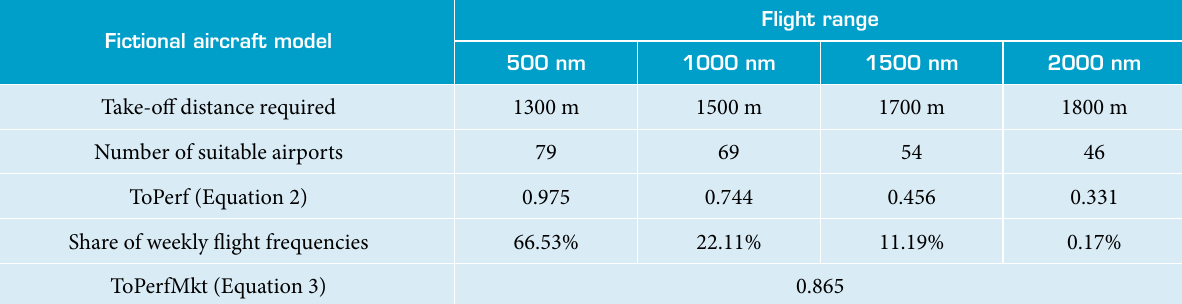
Table 2. Derivation process for fictional aircraft